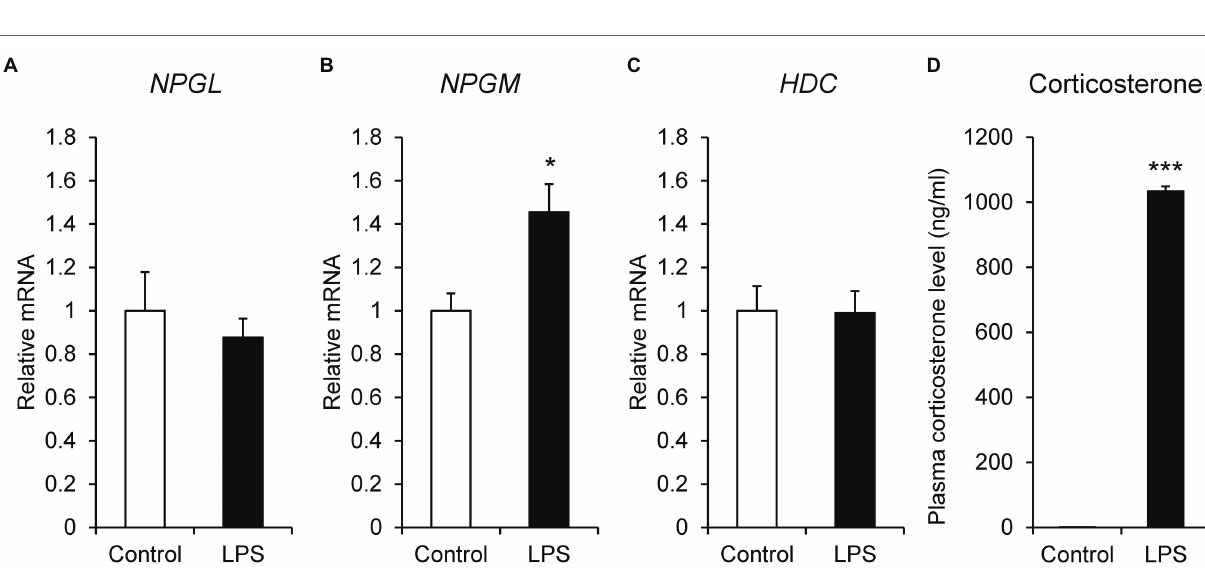
FIGURE 3 | mRNA expression levels, neurosecretory protein GL ( NPGL ; A ), neurosecretory protein GM ( NPGM ; B ), histidine decarboxylase ( HDC ; C ) in the mediobasal hypothalamus in the lipopolysaccharide (LPS)-induced inflammation stress experiment. Plasma corticosterone concentration level (D) . Data are expressed as the mean ± SEM ( n = 5–7). Data were analyzed by Student’s t -test. An asterisk indicates a statistically significant difference (* p < 0.05, *** p <